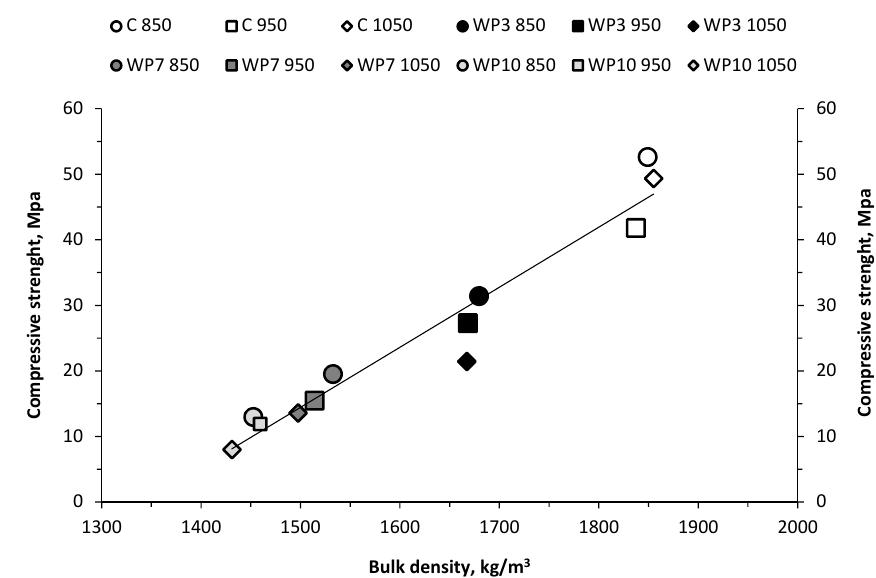
Figure 8. Relationship between bulk density and compressive strength of wet pomace bricks.